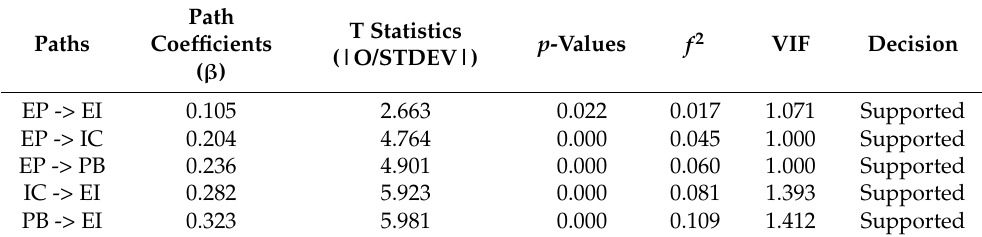
Figure 2. Measurement and structural model. Table 3. Path coefficients.